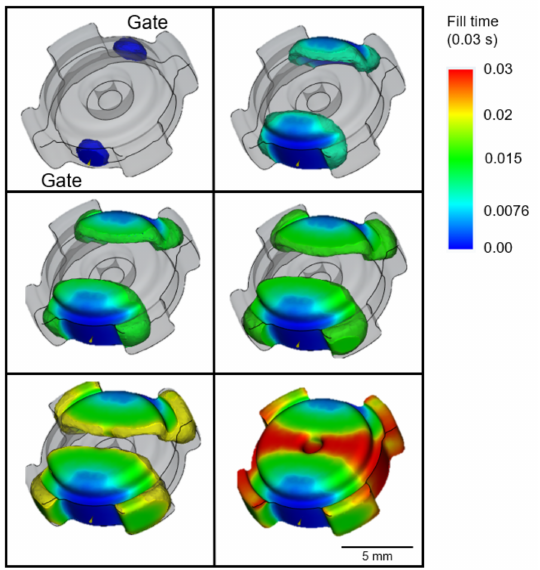
Figure 2. Filling